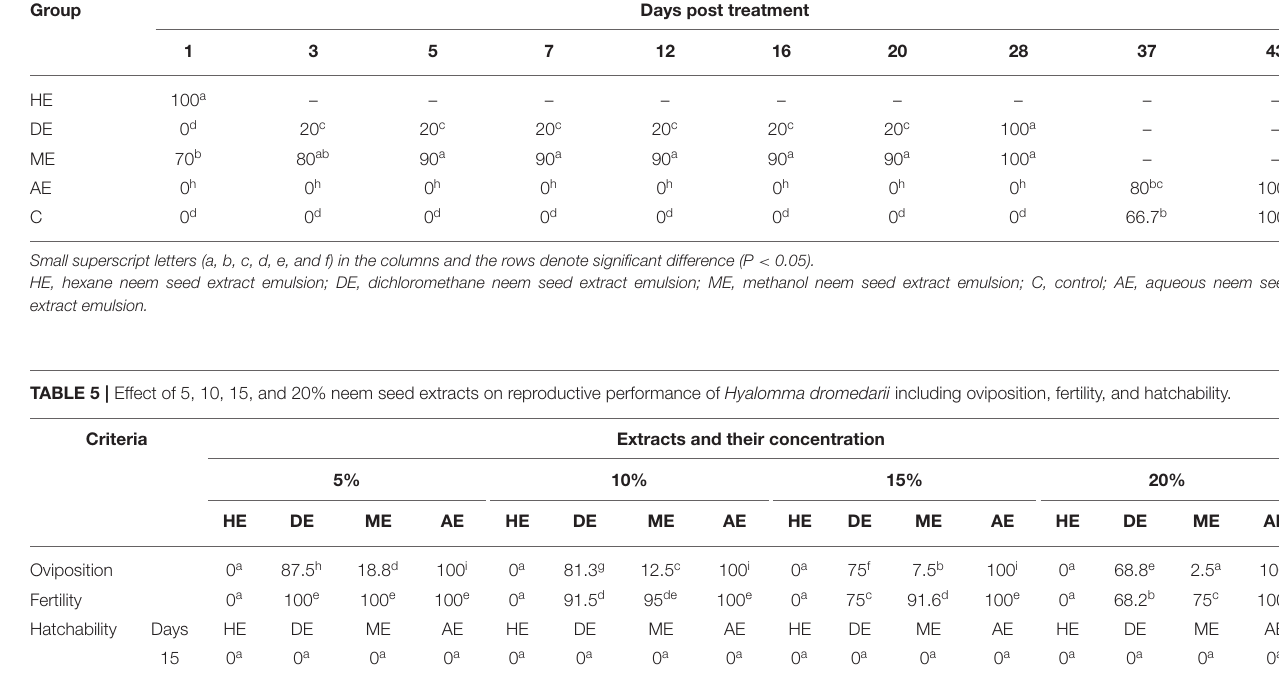
TABLE 4 | In vitro mortality rates of engorged Hyalomma dromedarii treated with 20% hexane, methanol, and dichloromethane extracts of neem seeds. Group Days post treatment